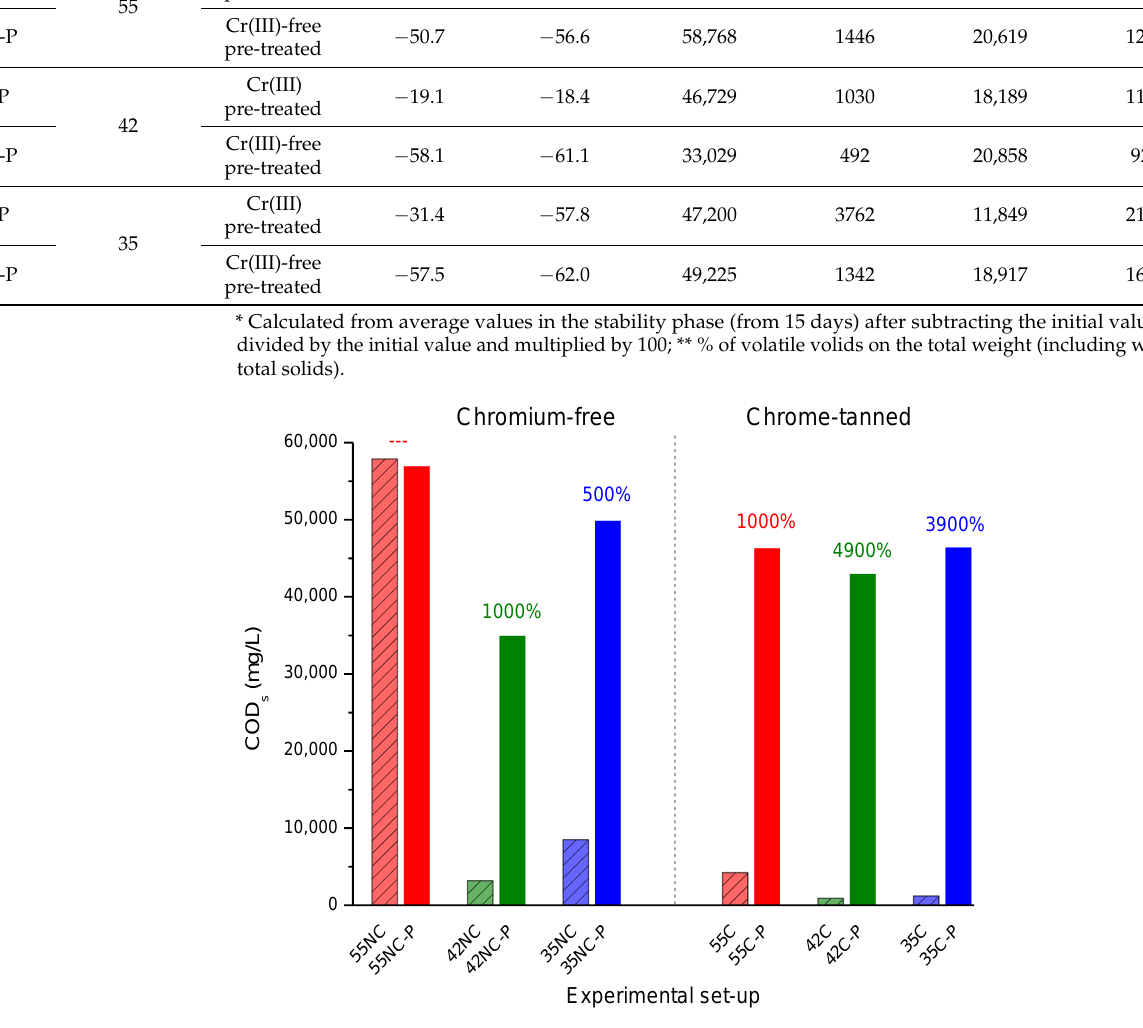
Figure 6. Solubilisation of the leather shavings expressed as CODs (mg/L) at different temperatures (55, 42, 35 ◦ C). Not pre-treated (-); pre-treated (P); with Cr(III) (C) and without Cr(III) (NC). On top of bars, increments over the not pre-treated